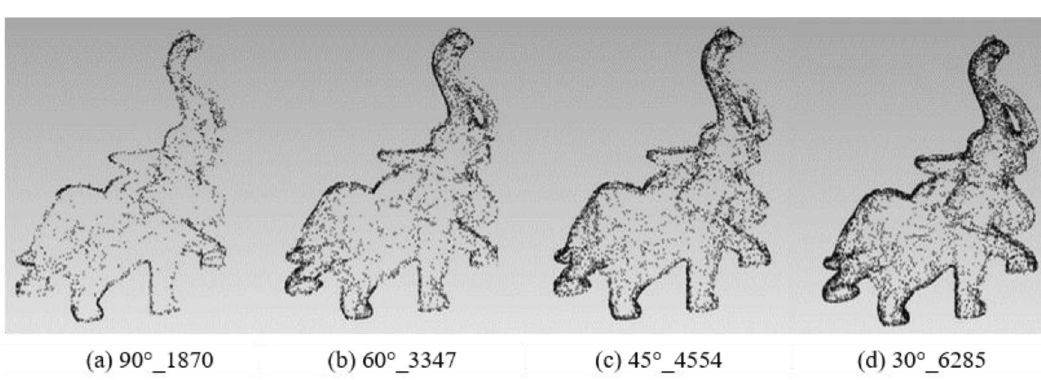
Figure 7. The point cloud with different numbers of feature points extracted with angles for Elephant.